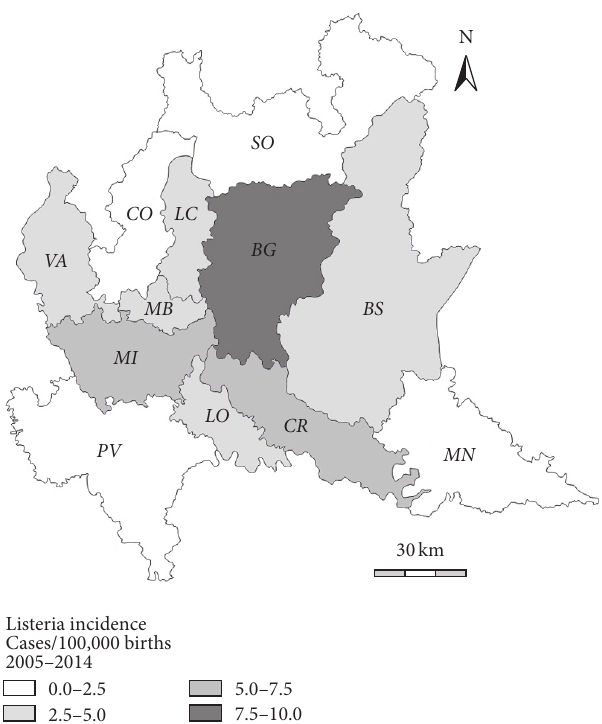
Figure 2: Geographical distribution of pregnancy-related listeriosis cases (per 100000 births) observed in Lombardy, Italy, from 2005 to 2014. BG: Bergamo; BS: Brescia; CO: Como; CR: Cremona; LC: Lecco; LO: Lodi; MN: Mantua; MI: Milan; MB: Monza Brianza; PV: Pavia; SO: Sondrio; VA: Varese .